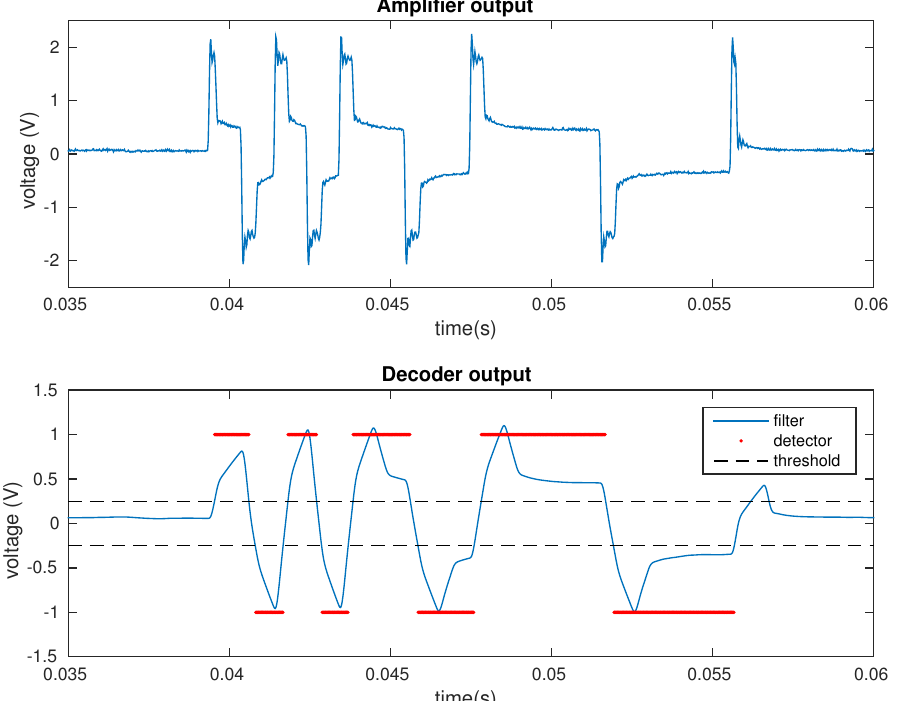
Figure 6. Data recorded by the system connected to the human forearm. Distance between driver and sensing electrodes was 12 cm.